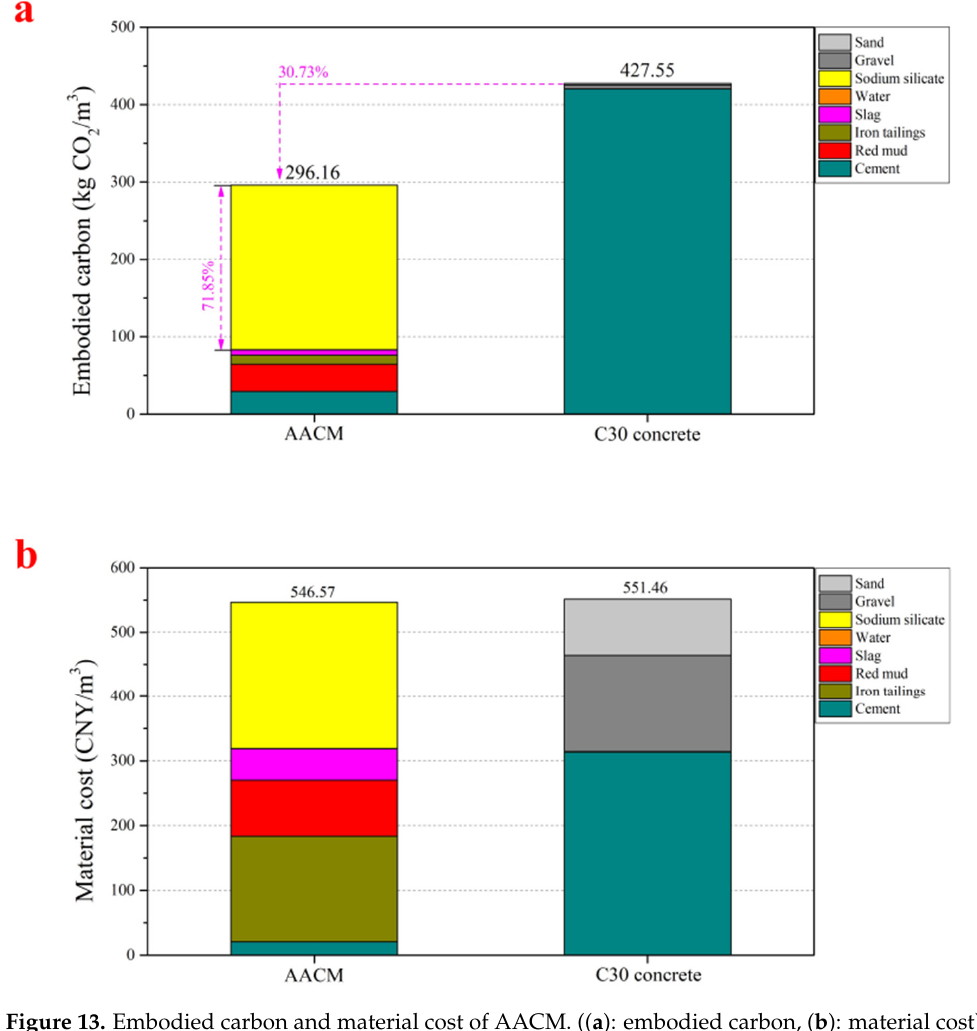
Figure 13. Embodied carbon and material cost of AACM. (( a ): embodied carbon, ( b ): material cost).